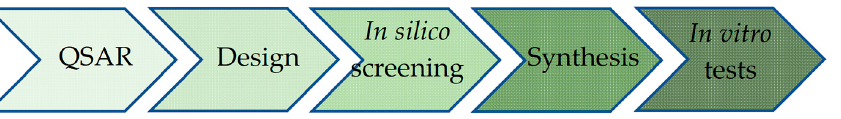
Figure 1. Flowchart of the present study. QSAR models were derived based on the literature data; the best models were used to design a series of potential new anticancer agents; the compounds were screened in silico for drug likeness and ADME properties; the most prospective ones were synthesized and tested in vitro on BC cell